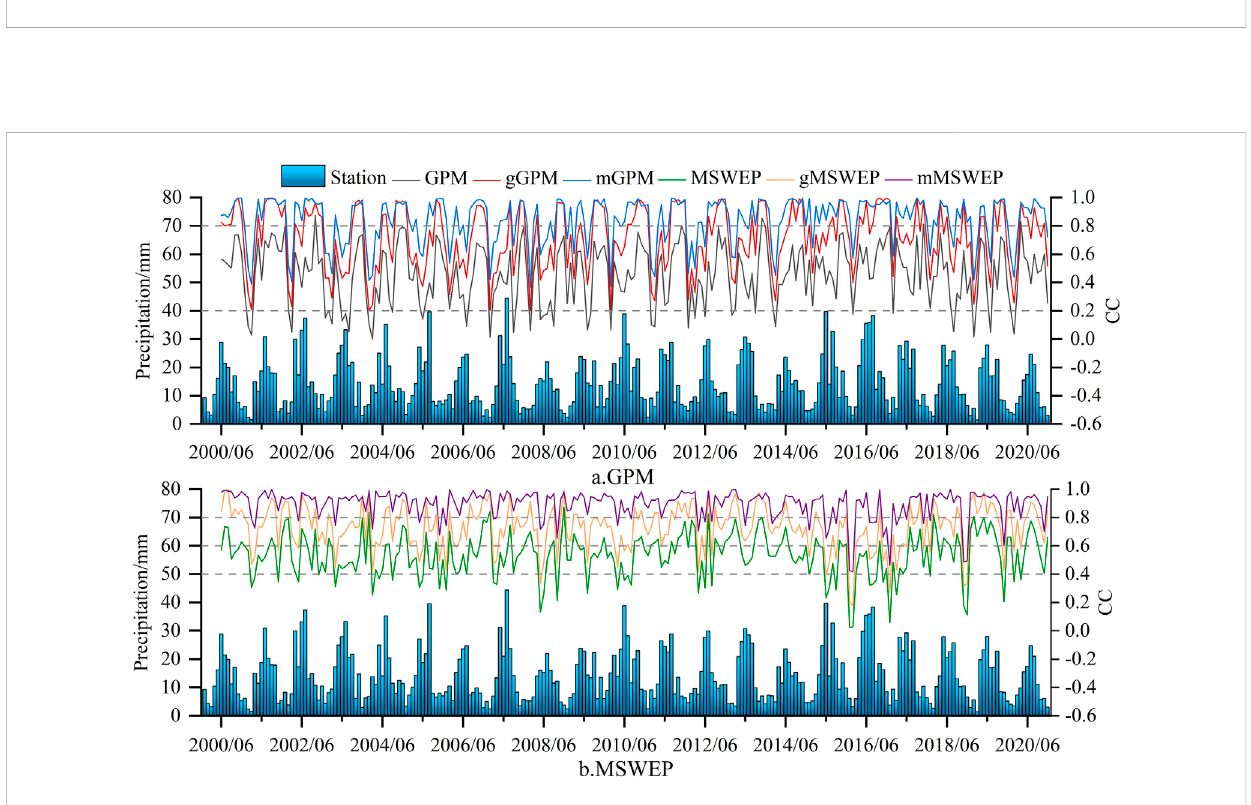
FIGURE 6 Time series changes of the measured precipitation and the correlation (CC) of GPM, MSWEP, the downscaling results and the measured precipitation (A) GPM and its downscaling results; (B) MSWEP and its downscaling results.